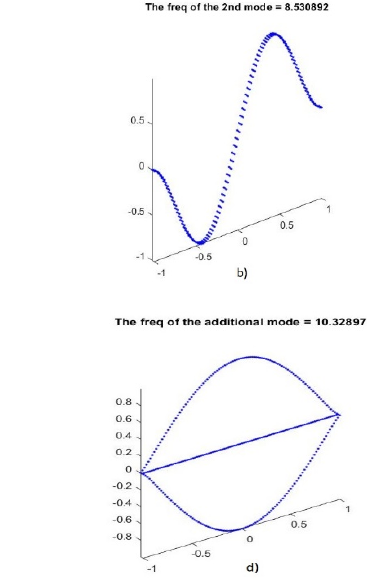
Figure 7. Vibrational modes of the beam: ( a ) 1st mode, ( b ) 2nd mode, ( c ) 3rd mode, ( d ) an additional mode related to the plate natural modes between the 2nd and the 3rd modes. Table 5. Natural frequencies in order of the material distribution and boundary conditions. λ B.